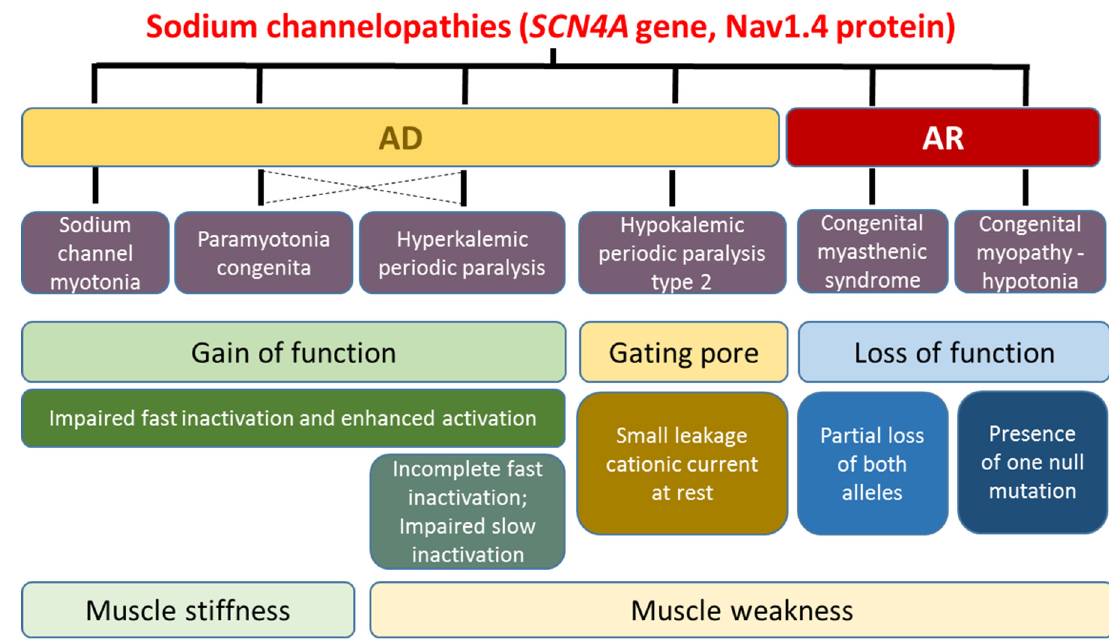
Figure 1. A schematic representation of skeletal muscle sodium channelopathies, reporting the mode of inheritance (AD: autosomal dominant; AR: autosomal recessive), disease name, mutation effects on sodium channel function, and main symptoms.